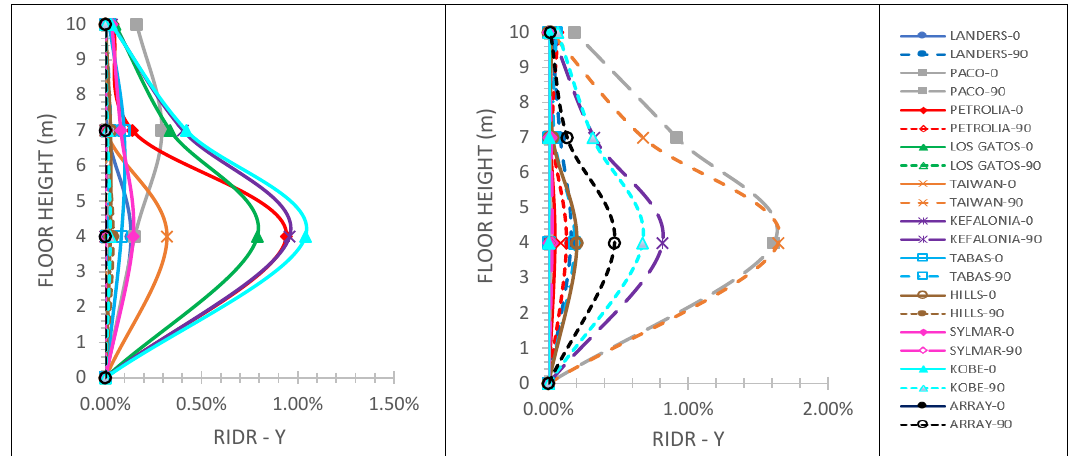
Figure 7. RIDR along X ( left ) and Y ( right ) horizontal directions of the three-story mixed building, considering the fixed connection of the steel structure to the r/c one.